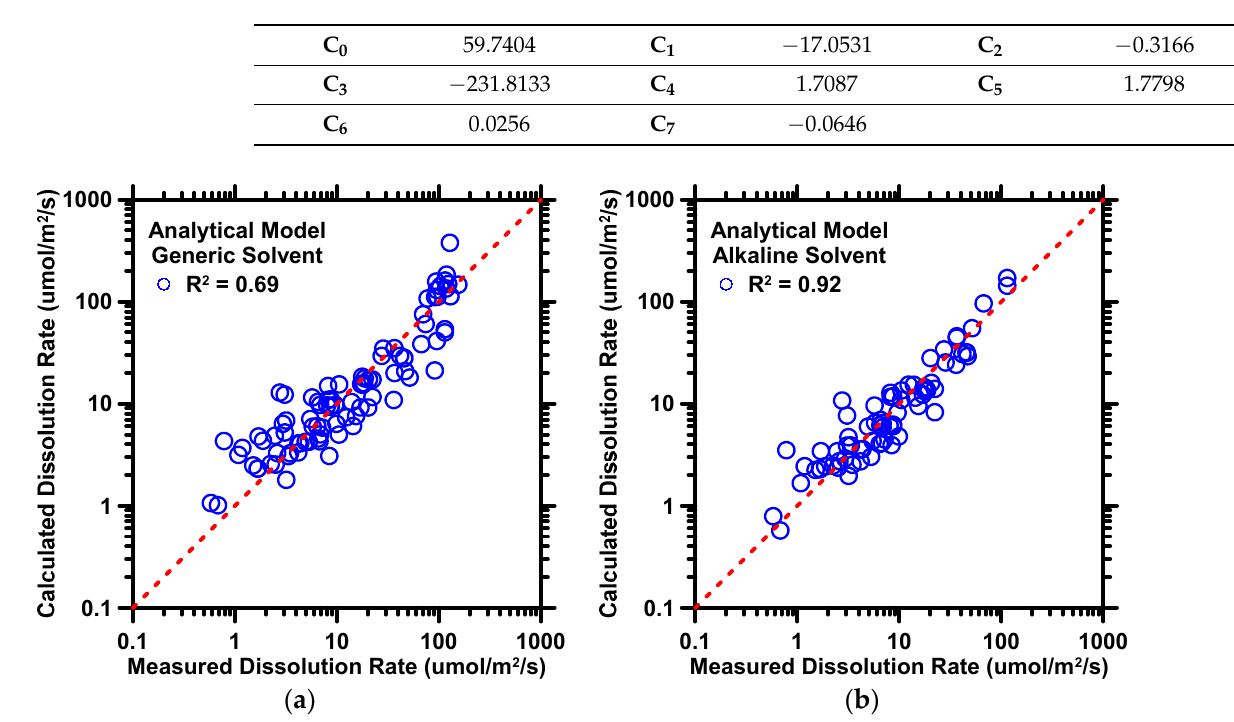
Figure 5. The analytical model’s predictions of C 3 S dissolution rate against experimental measure- ments for ( a ) generic solvent and ( b ) alkaline solvent. Coefficient of determination ( R 2 ) is shown in the legend, providing a measure of the prediction performance. The dashed line represents the ideal prediction. Table 5. R , R 2 , MAE , MAPE , and RMSE evaluating the prediction performance of the analytical model for generic and alkaline solvent scenarios against experimental measurements.